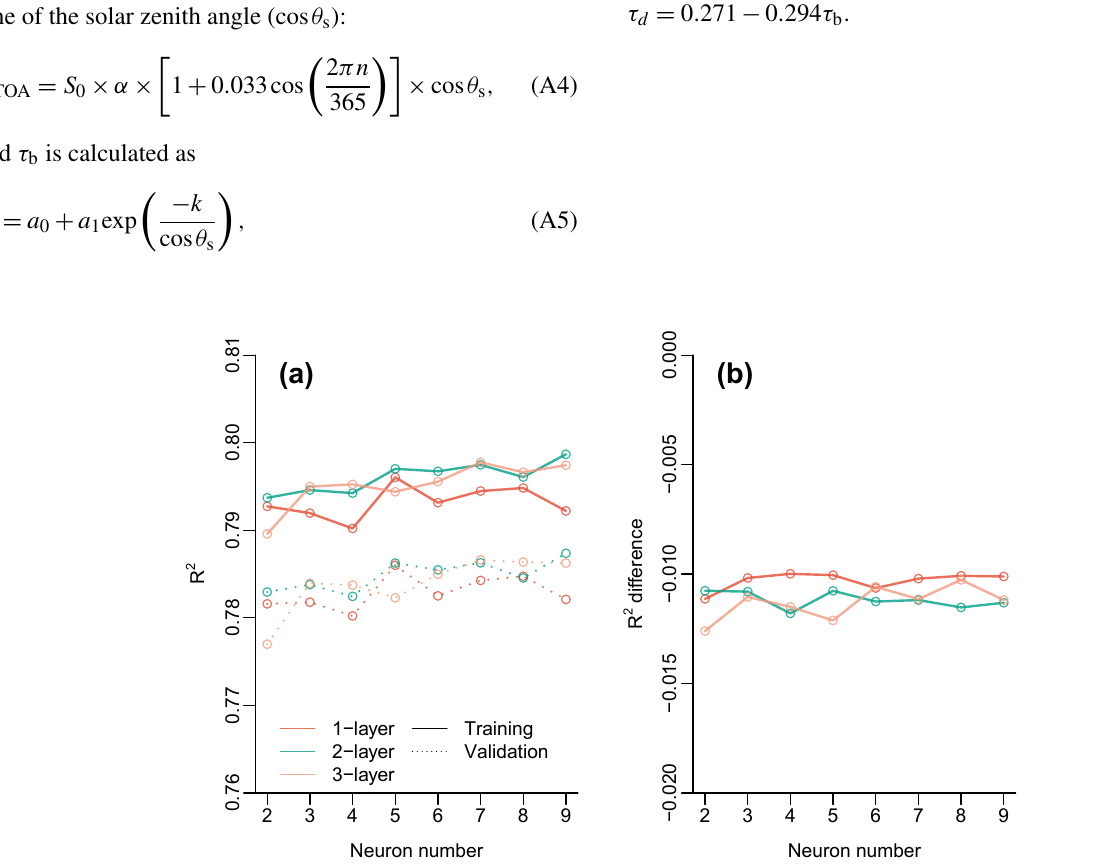
Figure A1. (a) Comparison of model performance ( R 2 ) during training and validation with a variety of NN layers (one to three) and neuron numbers for each layer (two to nine). (b) Difference of model performance between the training and validation for different layer and neuron